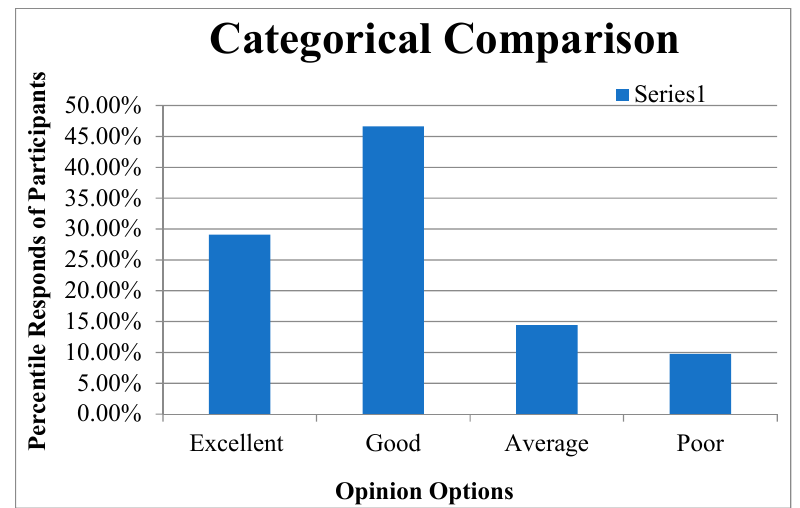
Figure 5. Categorical graph of comparison. Table 8. Group IV based on Questions